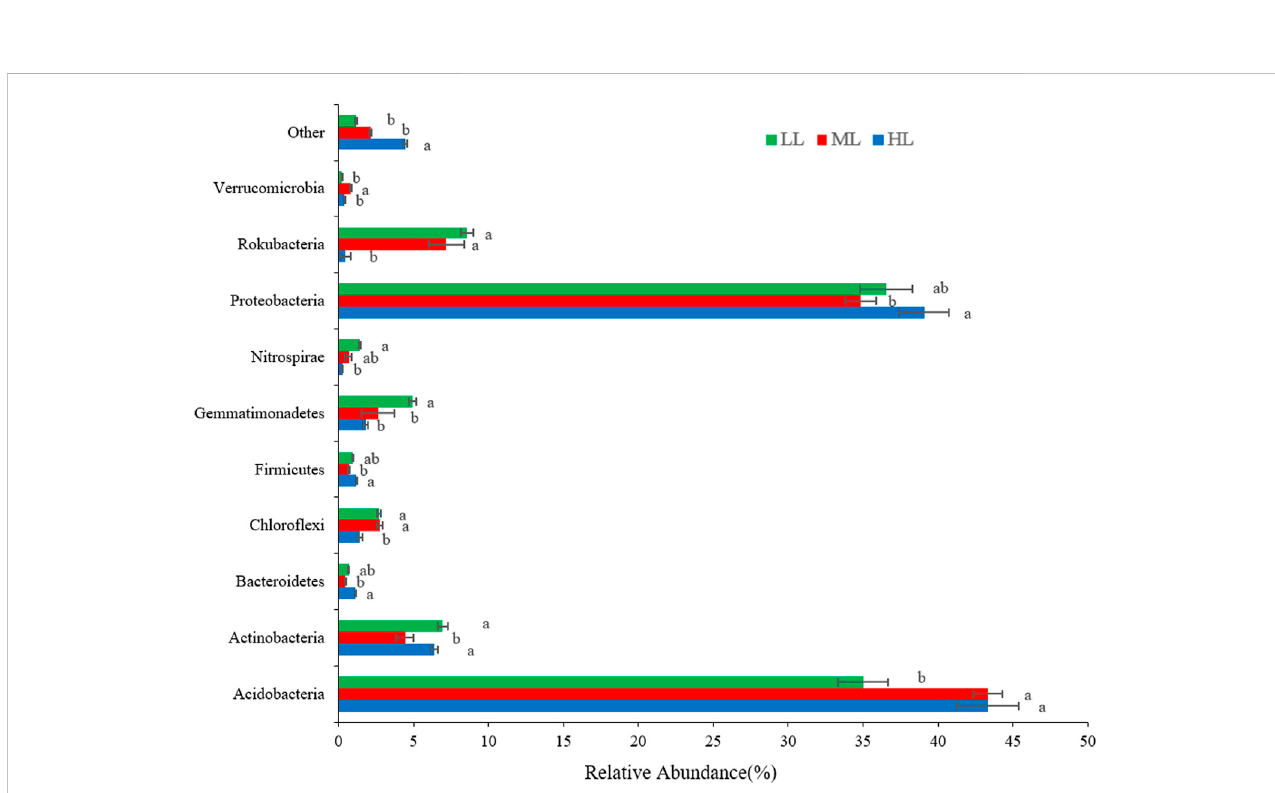
Histogram of the relative abundance of bacterial phyla detected in the forest soil at different latitudes. Different lowercase letters indicate signi fi cant differences at the p < 0.05 level among the treatments. LL, low-latitude; ML, mid-latitude; HL,